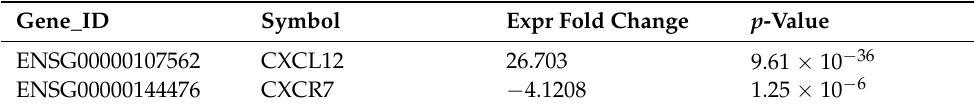
Table 4. Alterations of chemokines and receptors in xenograft LNCaP tumor as compared to LNCaP cultured cells.